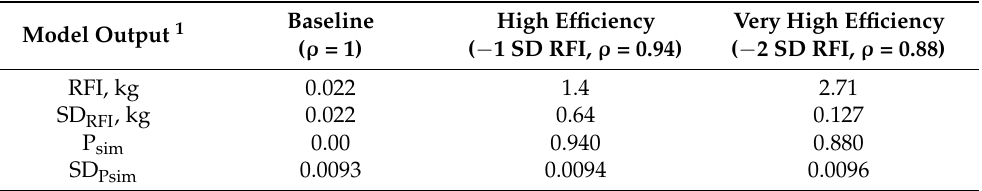
Table 3. Feed efficiency outcomes from 1000-cow herd simulations with 3 different input values for ρ for the Baseline ( ρ = 1), High Efficiency ( ρ = 0.94), and Very High Efficiency ( ρ = 0.88). Model Output 1.